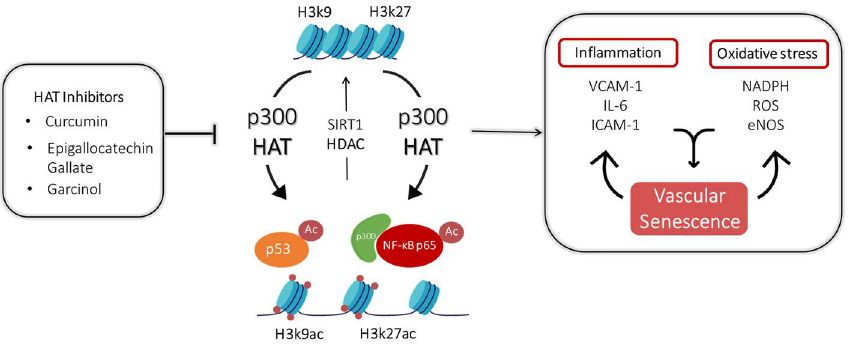
Figure 2. p300 mechanisms underlying vascular inflammation and oxidative stress and the role of some HAT inhibitors.